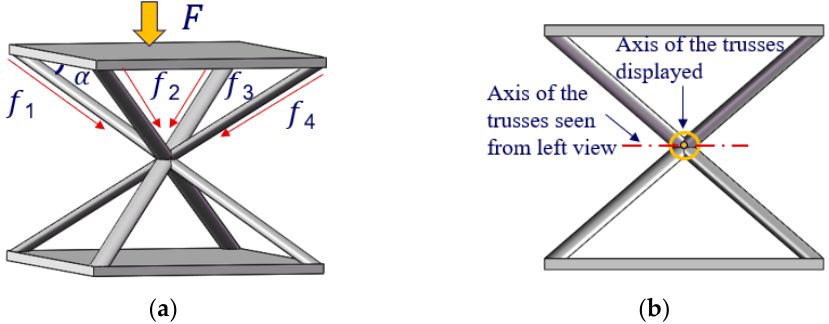
Figure 1. ( a ) Transmission of force load in a truss cell; ( b ) front view of the truss cell.